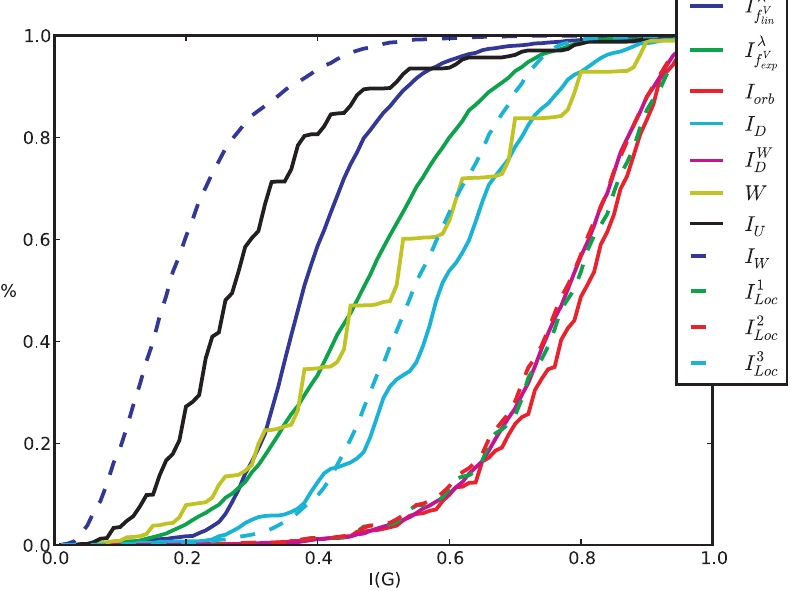
Figure 6. Cumulative Entropy Distributions for MS 2265. (reference label: cum_plot1). doi:10.1371/journal.pone.0008057.g006 PLoS ONE |